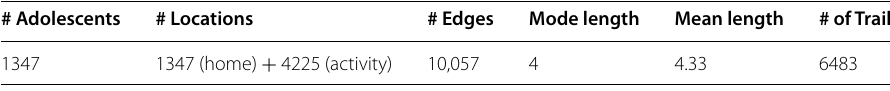
Table 1 The statistics of the trails on the AHDC dataset # Adolescents # Locations # Edges Mode length Mean length # of